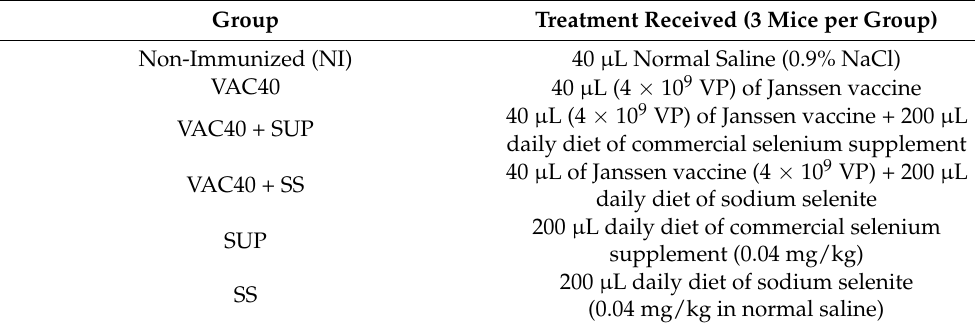
Table 1. Treatment formulations for mice